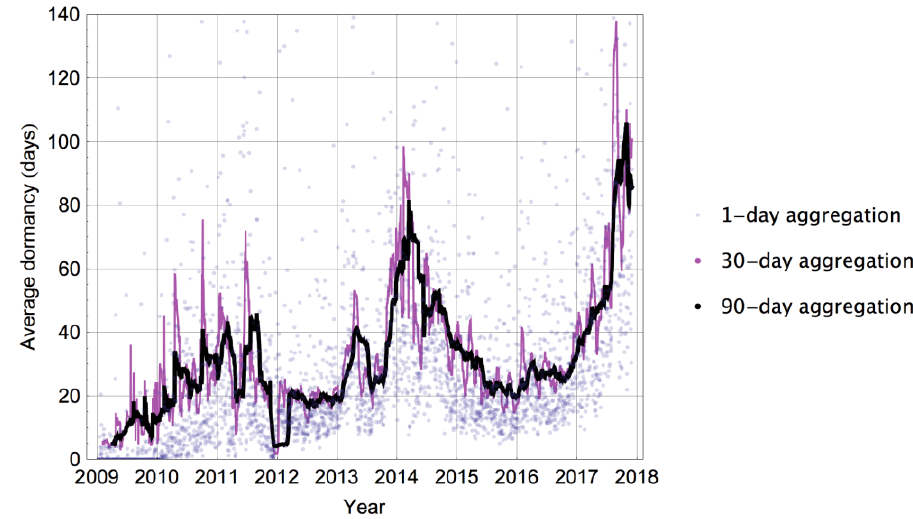
Fig. 1. Average dormancy over time using daily (blue dots), 30-day aggregated transactions (thin purple line), and 90 day aggregated transactions (thick black